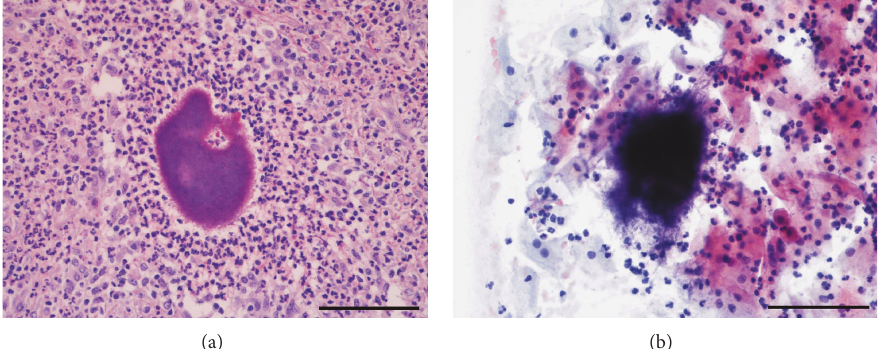
Figure 2: Cotton ball-like bacterial aggregates consistent with Actinomyces species infection in an HE-stained section of an ovarian abscess (a) and a Papanicolaou-stained cervical smear (b). Bar =